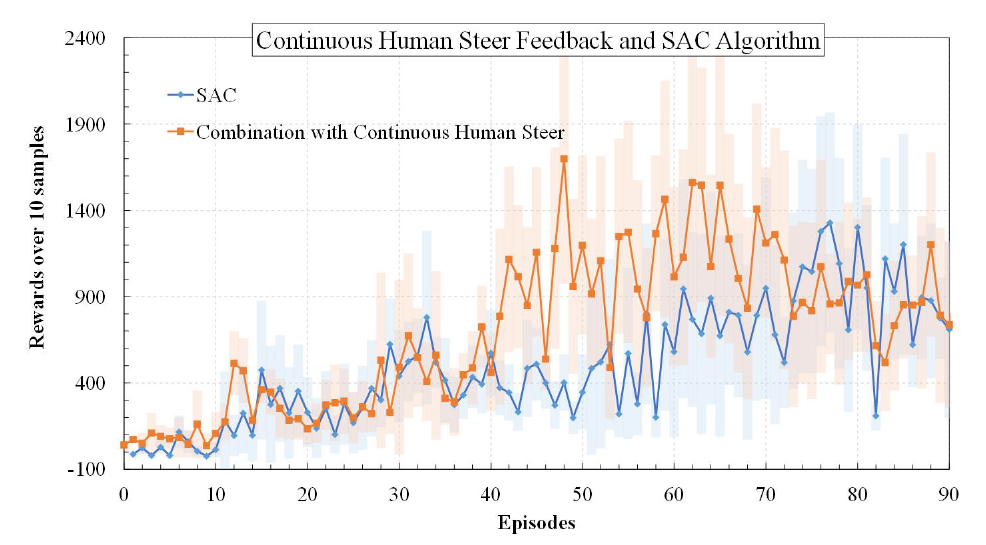
Figure 3. A comparison of baseline SAC with the proposed method engaged with human continuous feedback from steer averaged over 10 samples.